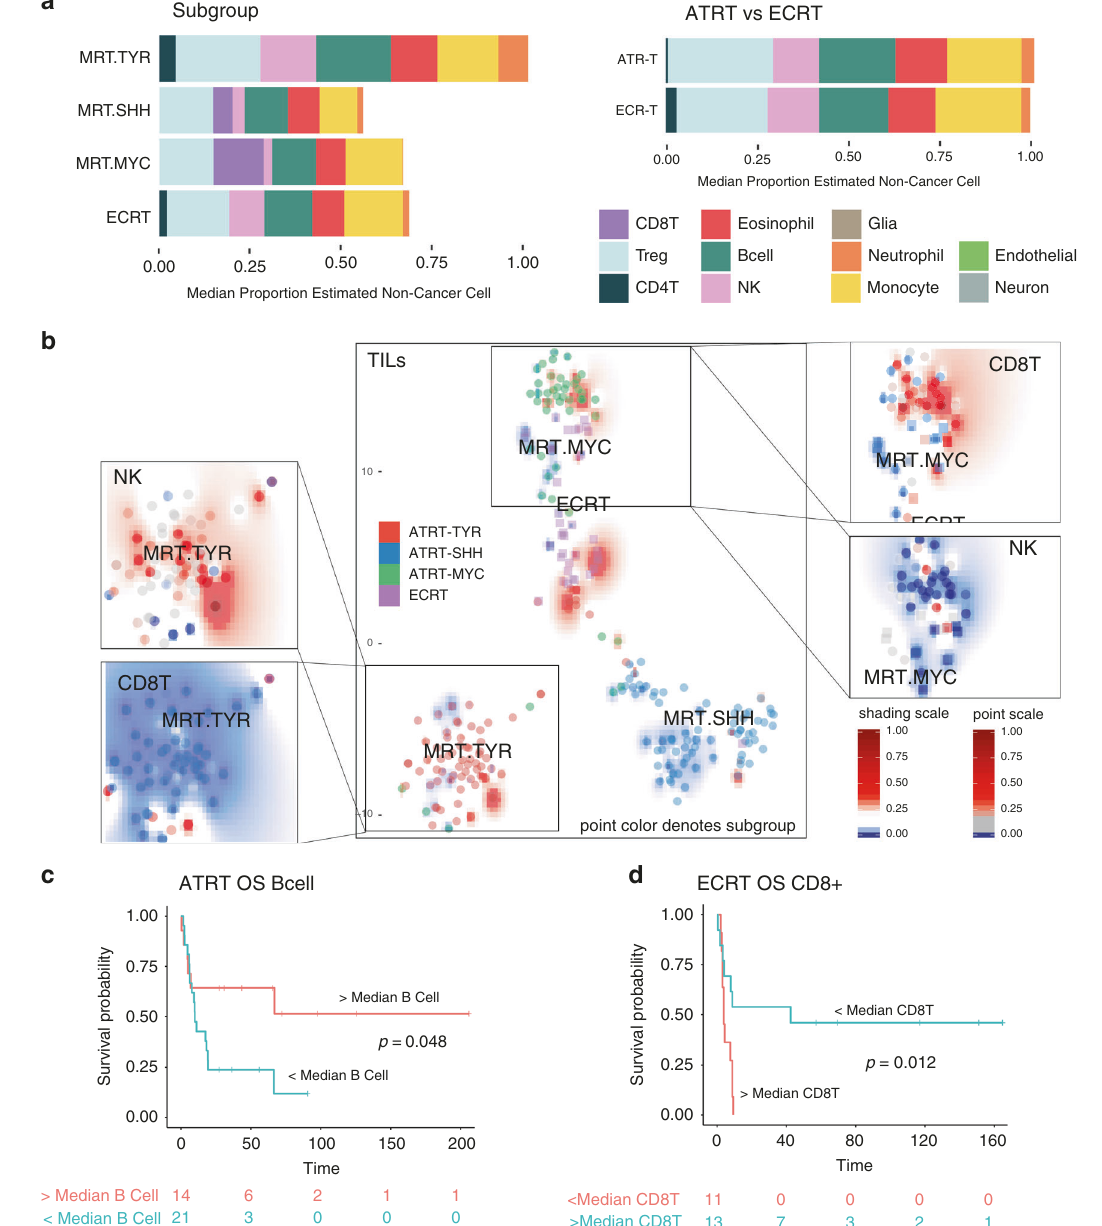
Fig. 4 Deconvolution analysis of malignant rhabdoid tumors immune in fi ltration. a Barplots of the estimated median in fi ltration of speci fi c cell types as a proportion of all non-cancer cell types (range scaled from 0 to 1) in 229 malignant rhabdoid tumors (MRTs) by subgroup (three molecular subgroups originally described by Johann et al. 36 ) and by tumor location. ATRT, atypical teratoid/rhabdoid tumor (within the CNS, i.e., intracranial); ECRT, extra- cranial rhabdoid tumor. b t-SNE plot representing the methylation pro fi les of 229 MRT. The colors of dots in the central panel map to molecular subgroups (as per Johann et al. 36 ). Text represents centroids of individual subtypes. Background shading represents the 2D spatial density estimation of the amount of tumor-in fi ltrating lymphocytes (TILs); red shading equals relatively greater than average in fi ltration and blue less than average. Exploded side panels represent enlarged areas of interest wherein both dot color and background shading represent the relative amount of the particular immune cell in fi ltration denoted. Red denotes relatively greater than average in fi ltration and blue less than average. c Kaplan – Meier plot showing signi fi cantly different overall survival (OS) in ATRT with > or <median numbers of B-cells; log-rank, p = 0.048, n = 35. d Kaplan – Meier plot showing signi fi cantly different overall survival (OS) in ECRT with > or <median numbers of CD8 + T-cells; log-rank, p = 0.012, n = mutations was associated with higher immune cell in fi ltration, in fi ltration were available, which categorized patients as per speci fi cally of monocytes and CD4T cells ( W = 3614 and W = Rutledge et al. 47 . Estimates of TILs were signi fi cantly greater in patients classi fi ed as Categories 1 (present) or 2 (abundant) than 3453, respectively, both p < 0.001). In addition, nine patients who Category 0 (absent) ( F = 7.839, p < 0.01, n = 61). Again, taken as a possessed a hypermutator phenotype showed a signi fi cantly higher whole, the signi fi cant relationships between molecular subgroup, estimated levels of TILs (KW = 5.0, p = 0.025, n = 137). For a prognosis, mutation, and immune in fi ltration in pHGG are clear. subset of samples, histopathology-based estimates of lymphocyte